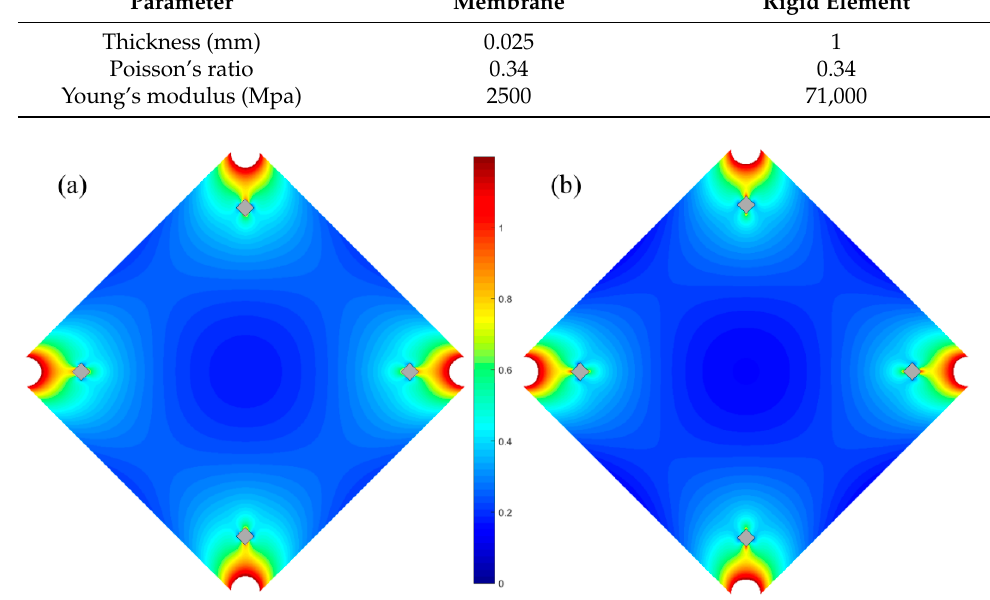
Figure 2. The first principal stress of a film with four rigid elements: ( a ) analytical solution; ( b ) finite- element solution.